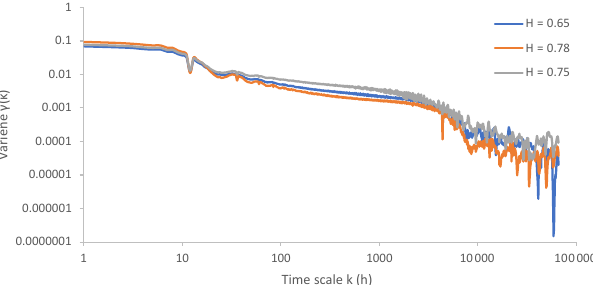
Figure 3. Climacogram of three investigated stations: Denver, H = 0 . 78, Elizabeth city, H = 0 . 75, Bluefield Virginia, H = 0 .